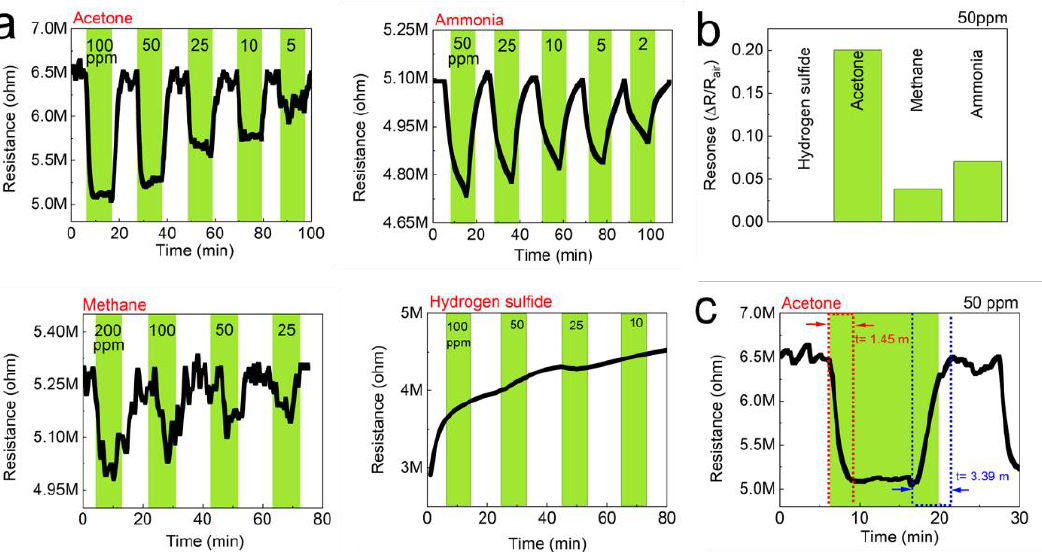
Figure 7. Gas-sensing performance of the TOCNF/G sensors against acetone, ammonia, methane, and hydrogen sulfide at room temperature. ( a ) Real-time resistance behavior of the TOCNF/G sensors as a function of the concentration of the test gases; acetone, ammonia, methane, and hydrogen sulfide. ( b ) Gas response of the TOCNF/G sensors to 50 ppm of the test gases, ( c ) Gas response time of the TOCNF/G sensors to 50 ppm of acetone.